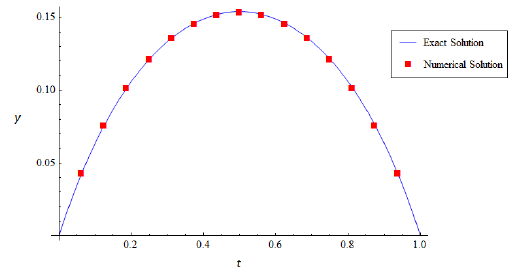
Figure 13. Graphical comparison of exact and numerical solution of Problem 2.